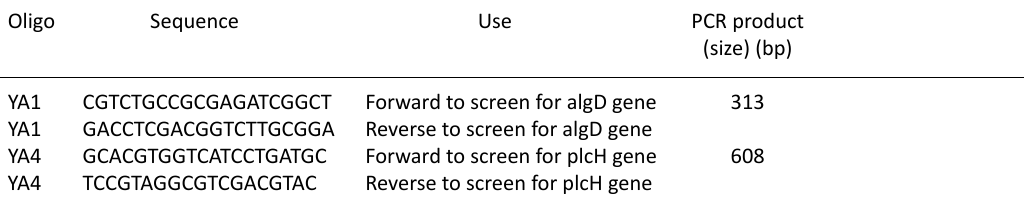
Table 1. Primers used in this paper